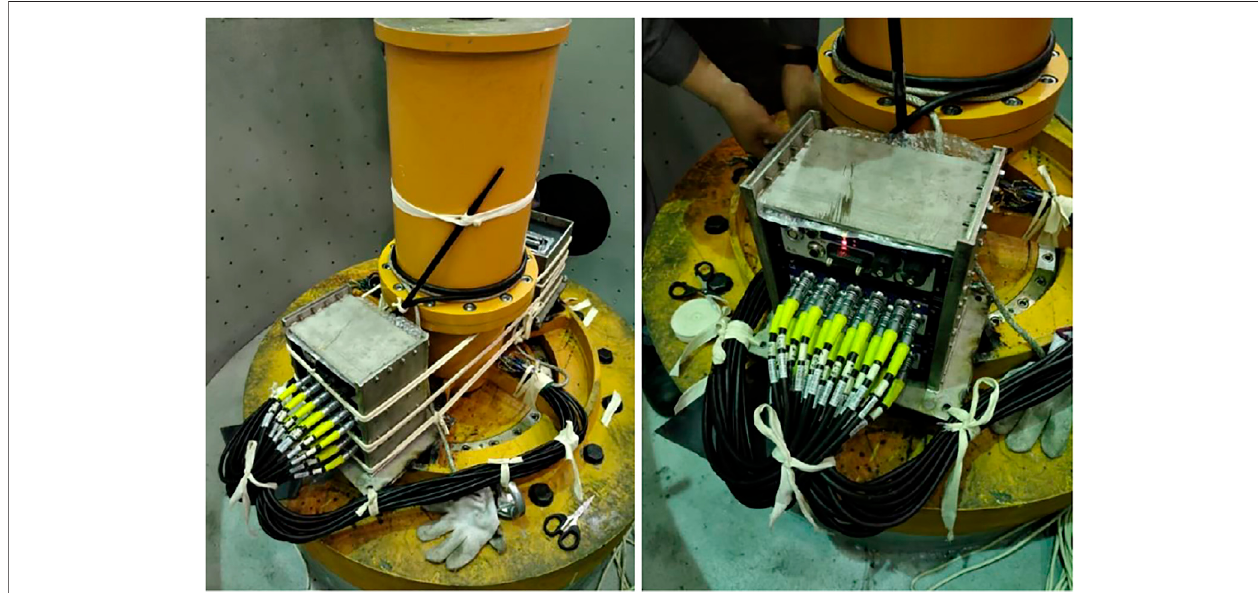
FIGURE 7 | The photos of data acquisition equipment fi xed by bolts and welding.